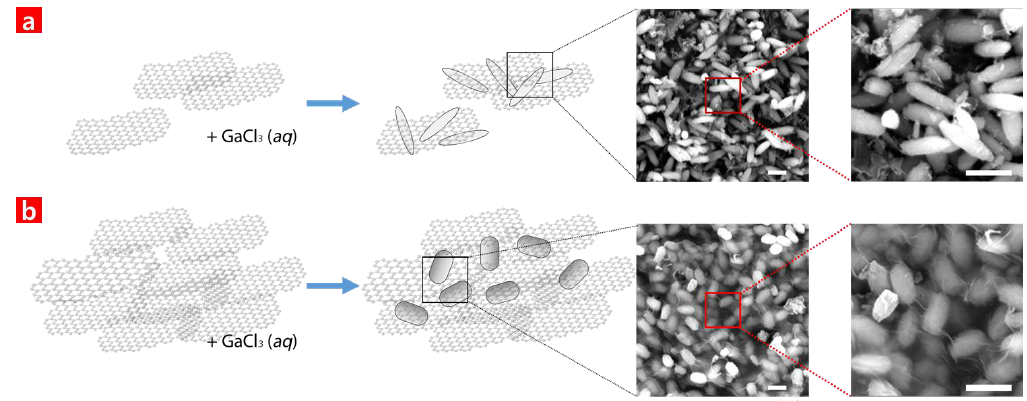
Figure 1. Schematic illustrations of hybrid composite (HC) growth depending on ( a ) a 4% graphene oxide (GO) solution and ( b ) a 10% GO solution. The scale bar in the scanning electron microscopy (SEM) is 1 μm.